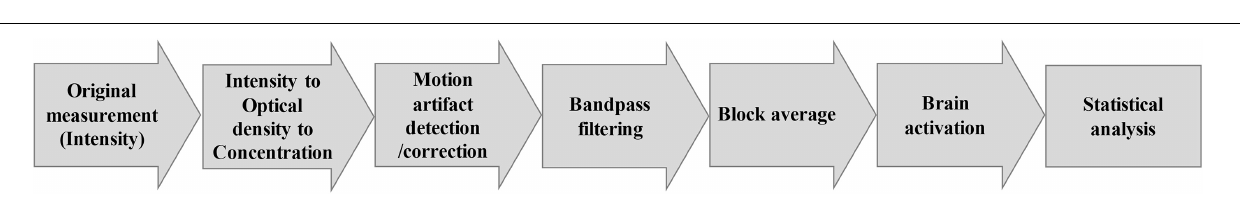
FIGURE 2 | fNIRS channel and probe configuration. (A) The 2D map illustrated the distribution of probes (red and blue representing the source and detector probe, respectively) and 20 channels. (B) The 3D map showed the positioning of channels. L, the left hemisphere of brain; R, the right hemisphere of brain; IFG, inferior frontal gyrus; MFG, middle frontal gyrus.